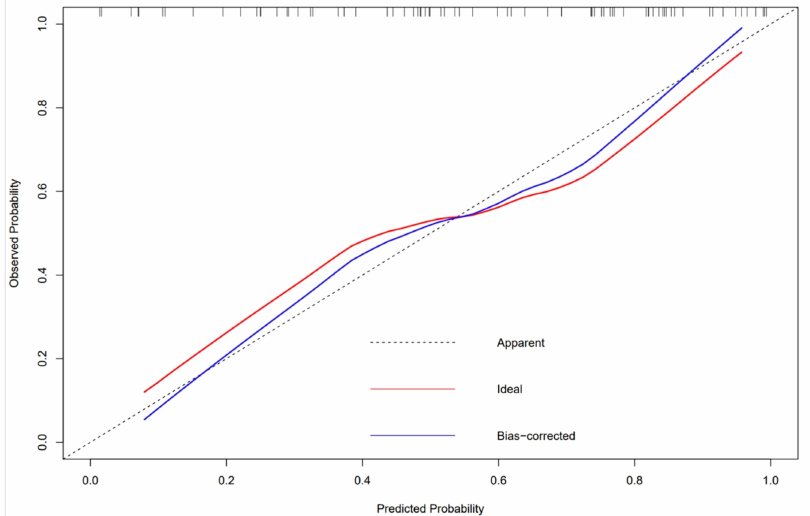
Figure 5. Calibration curve. The red line represents ideal predictions. The plot illustrates the accuracy of the best-fit model (Apparent) and the validation model (Bias-corrected) for predicting vaginal delivery.